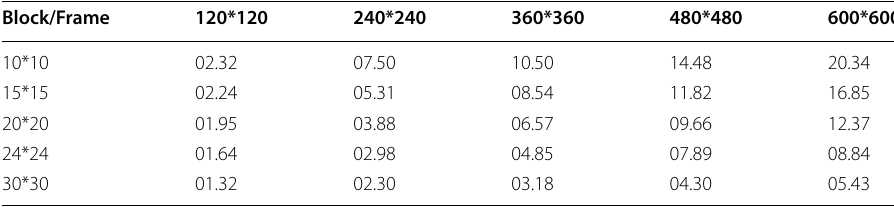
Table 5 Average processing time (APT) of S ∗ (by second)